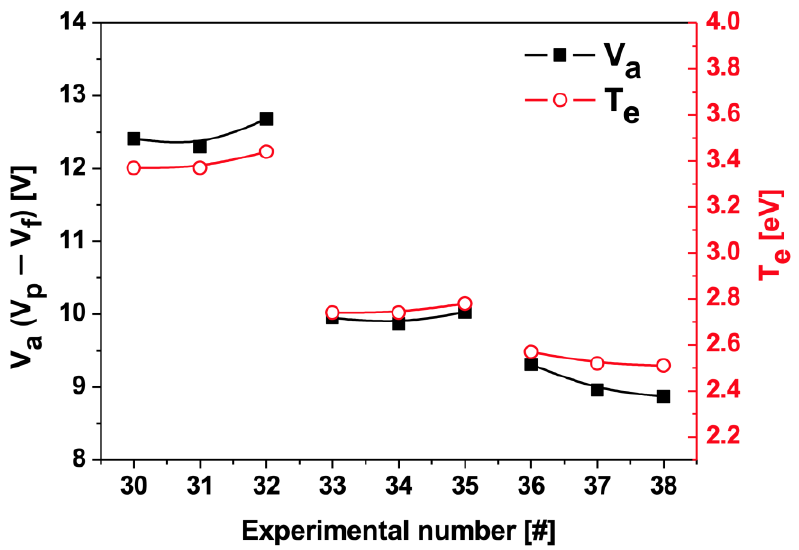
Figure 5. Electron temperature and acceleration potential for different operation condition in the PN-ICP system.